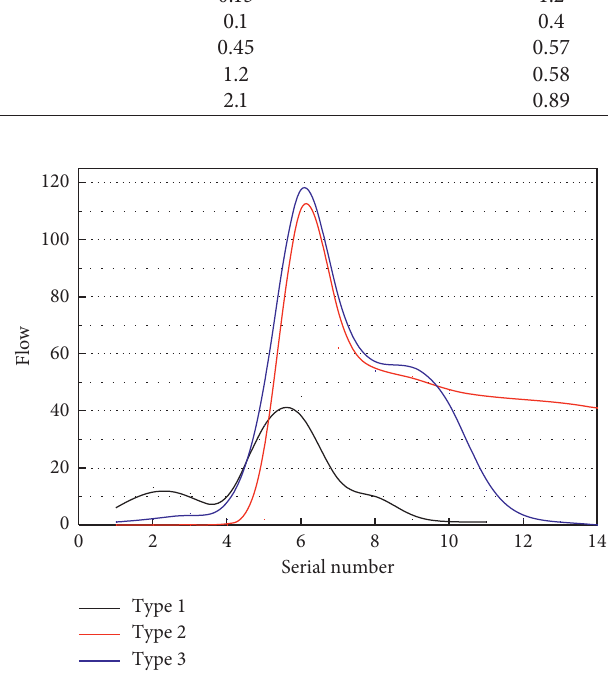
Figure 3: Training loss function diagram of CNN-LSTM model in MOT16 dataset.